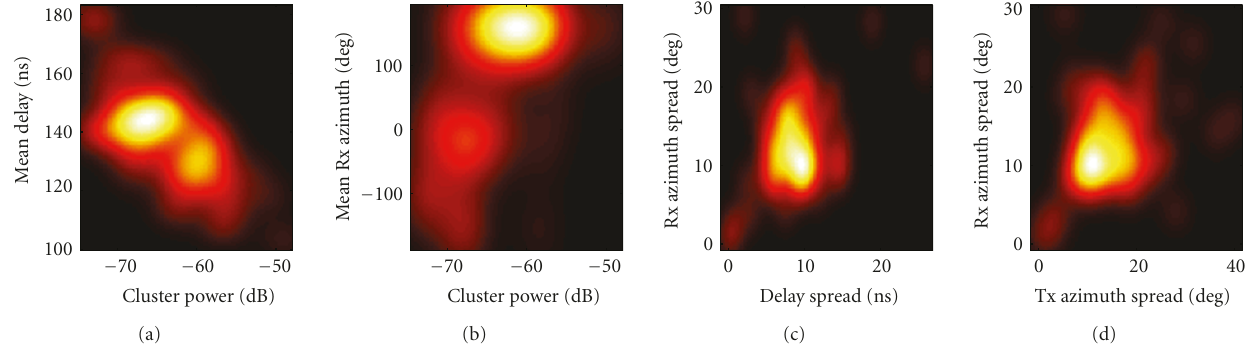
Figure 3: Exemplary marginal distributions of the environment